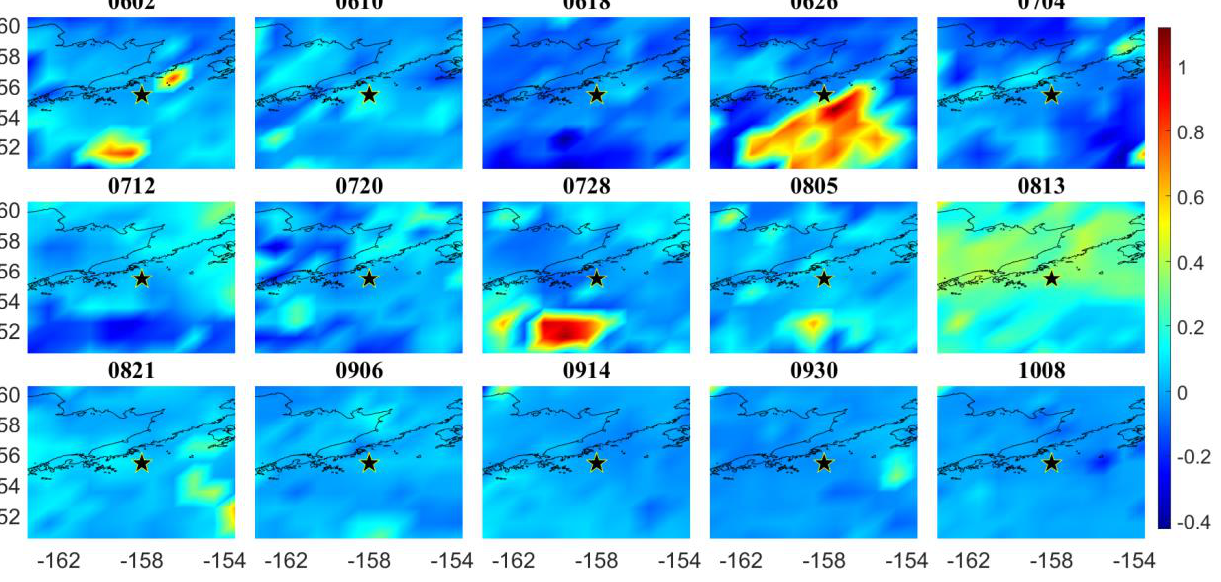
Figure 8. The variation in 8 days averaged AOD during the EQ time after removal of the back- ground, which is built by AOD values from 2001 - 2021 over the Alaska epicenters.